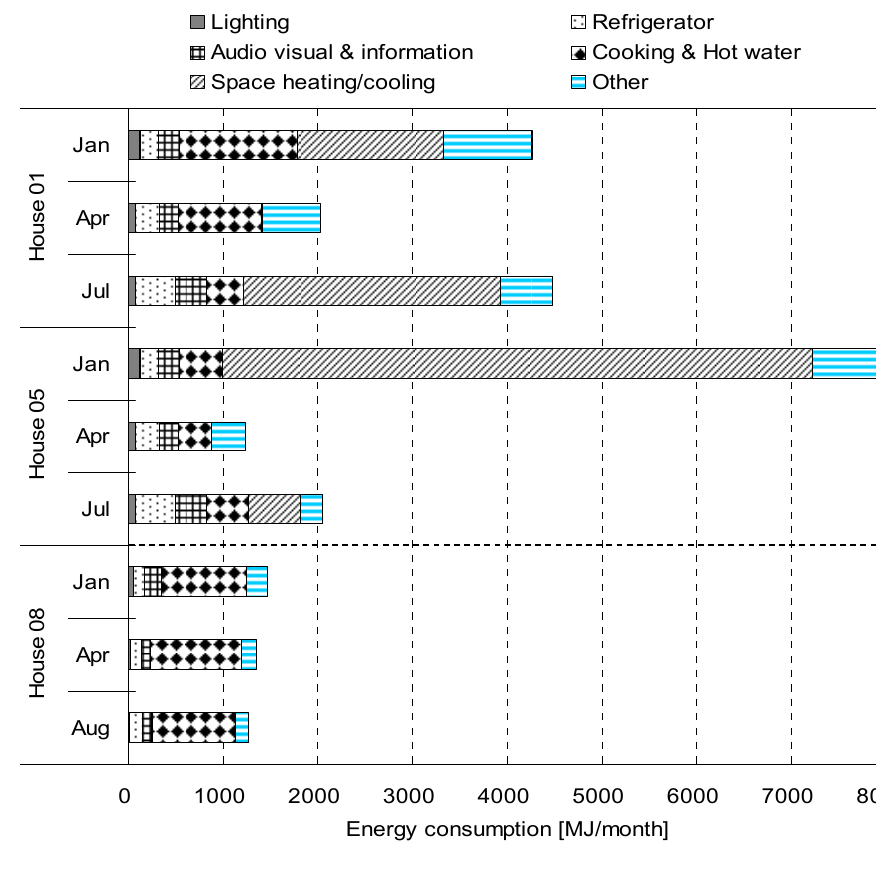
Figure 6. Energy use in the month of winter, spring and